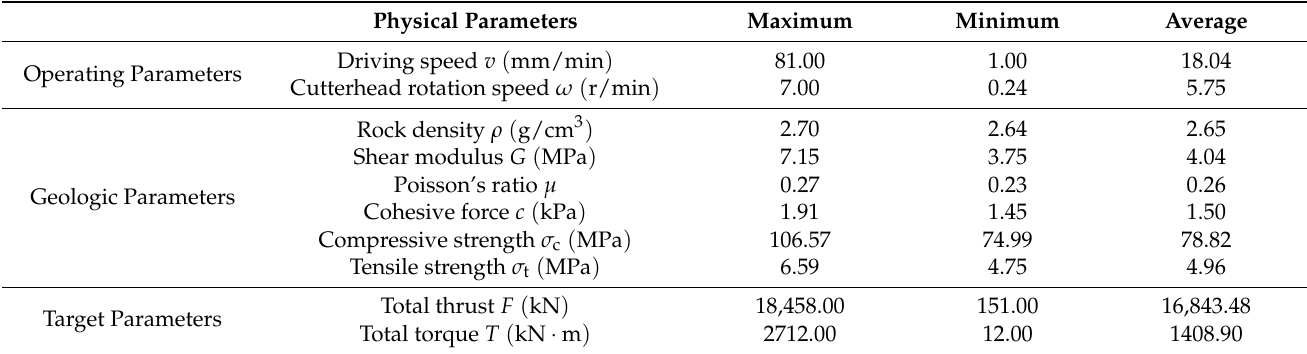
Table 3. The statistical characteristics of the